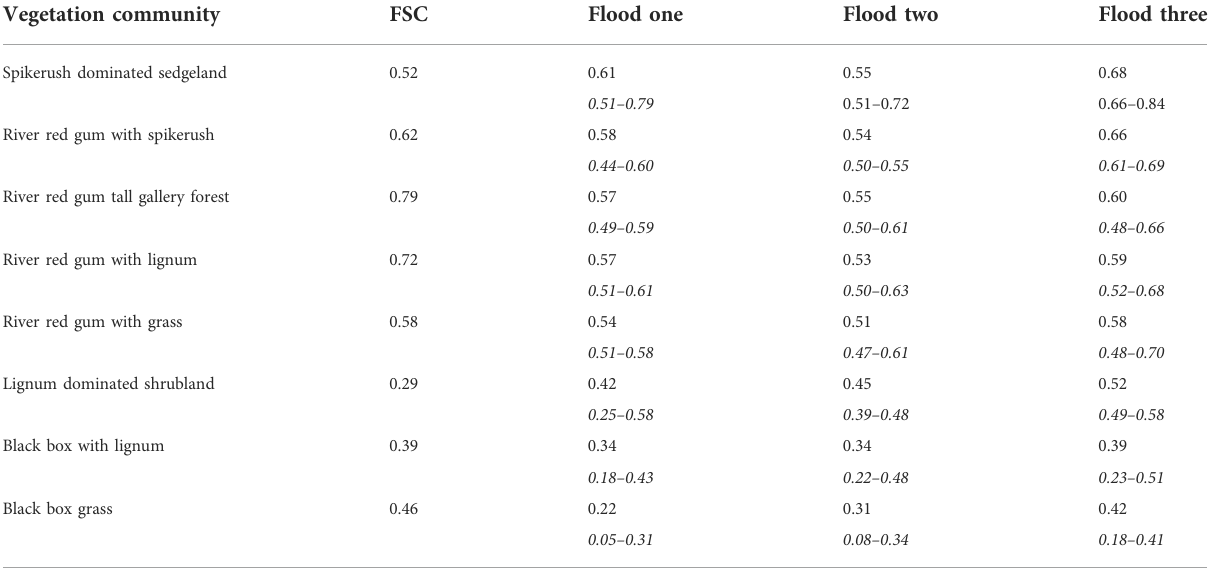
TABLE 3 Floodplain vegetation response to inundation. The mean and range of NDVI values (ranges are in italics) for each vegetation community during the three fl ood events are provided. Vegetation community